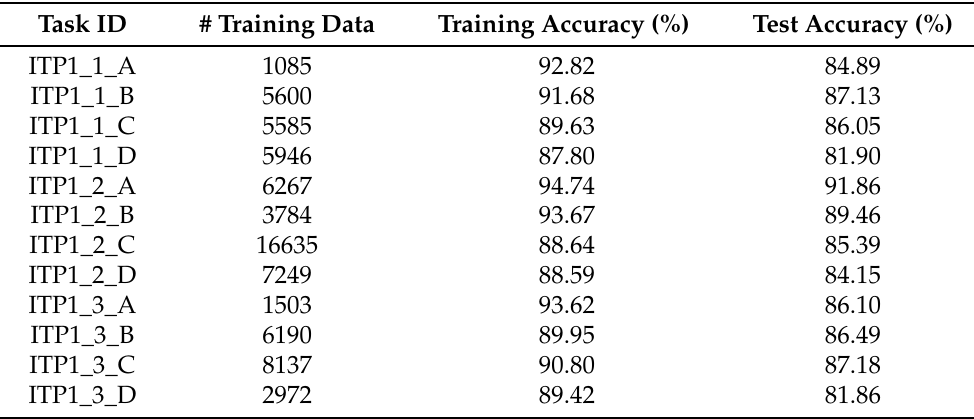
Table 4. Training and test accuracy of